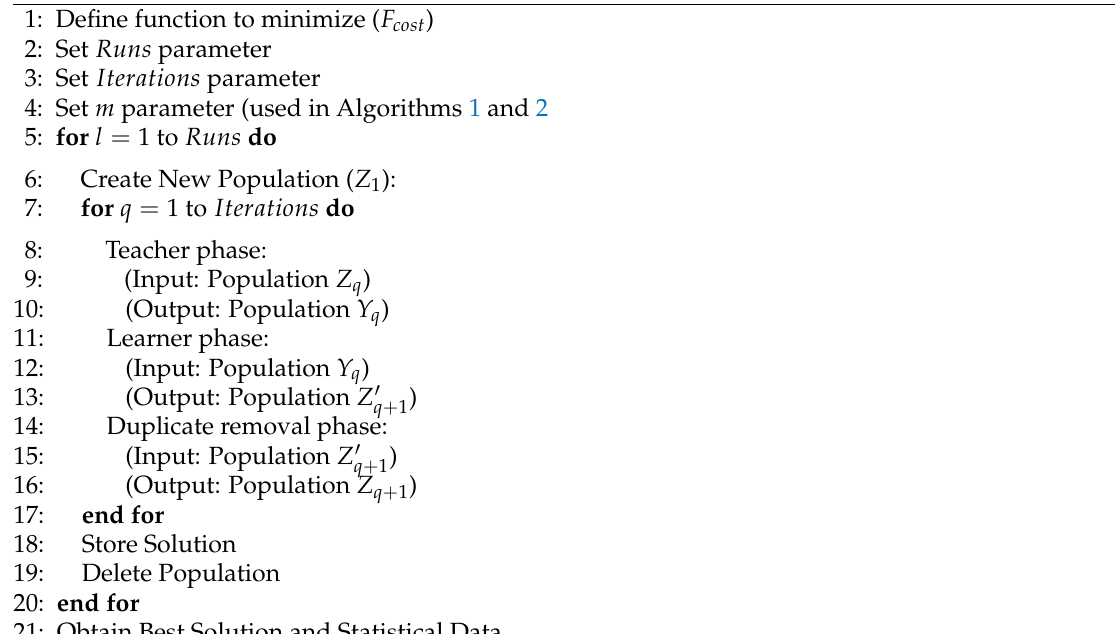
Algorithm 3 Skeleton of the sequential TLBO